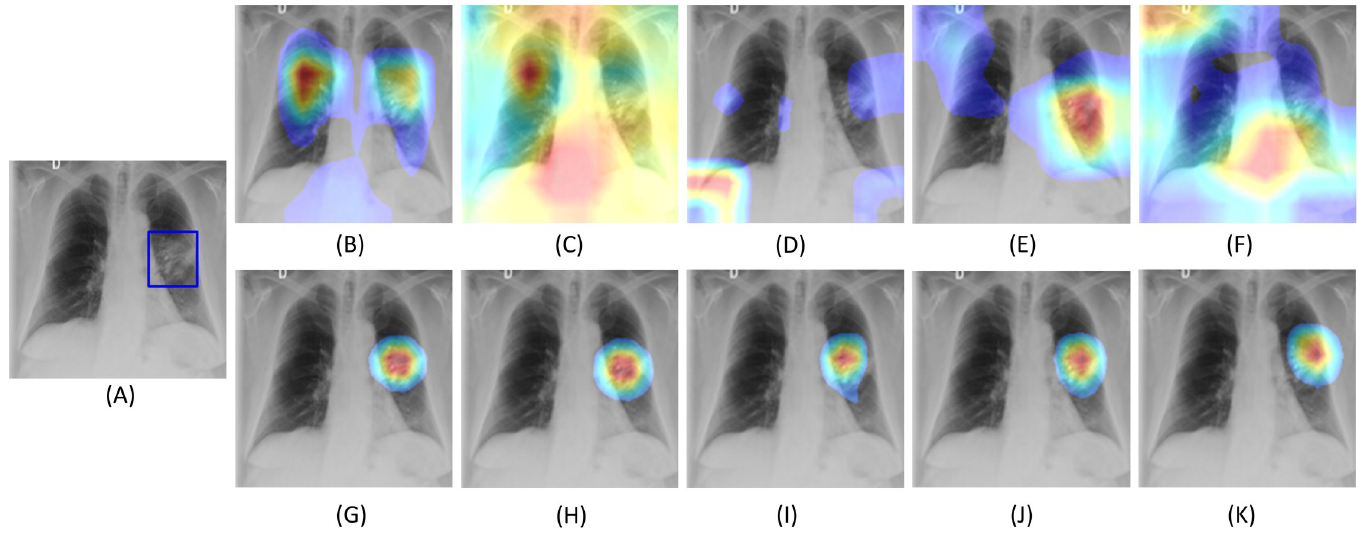
Fig 12. COVID-19 viral disease ROI CRM-based localization achieved using the fine-tuned models and their baseline counterparts. (A) Original CXR with STAPLE- generated consensus ROI (shown as blue box ROI); (B) Baseline VGG-16; (C) Baseline VGG-19; (D) Baseline MobileNet-V2; (E) Baseline ResNet-18; (F) Baseline Inception-V3; (G) Fine-tuned VGG-16; (H) Fine-tuned VGG-19; (I) Fine-tuned MobileNet-V2; (J) Fine-tuned ResNet-18; (K) Fine-tuned Inception-V3.